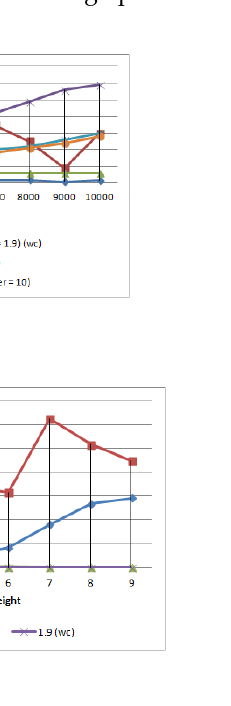
Figure 7. Element update operations. ( a ) average messages, ( b ) load-balancing rate of winner D 3 -Tree, ( c ) load-balancing height of winner D 3